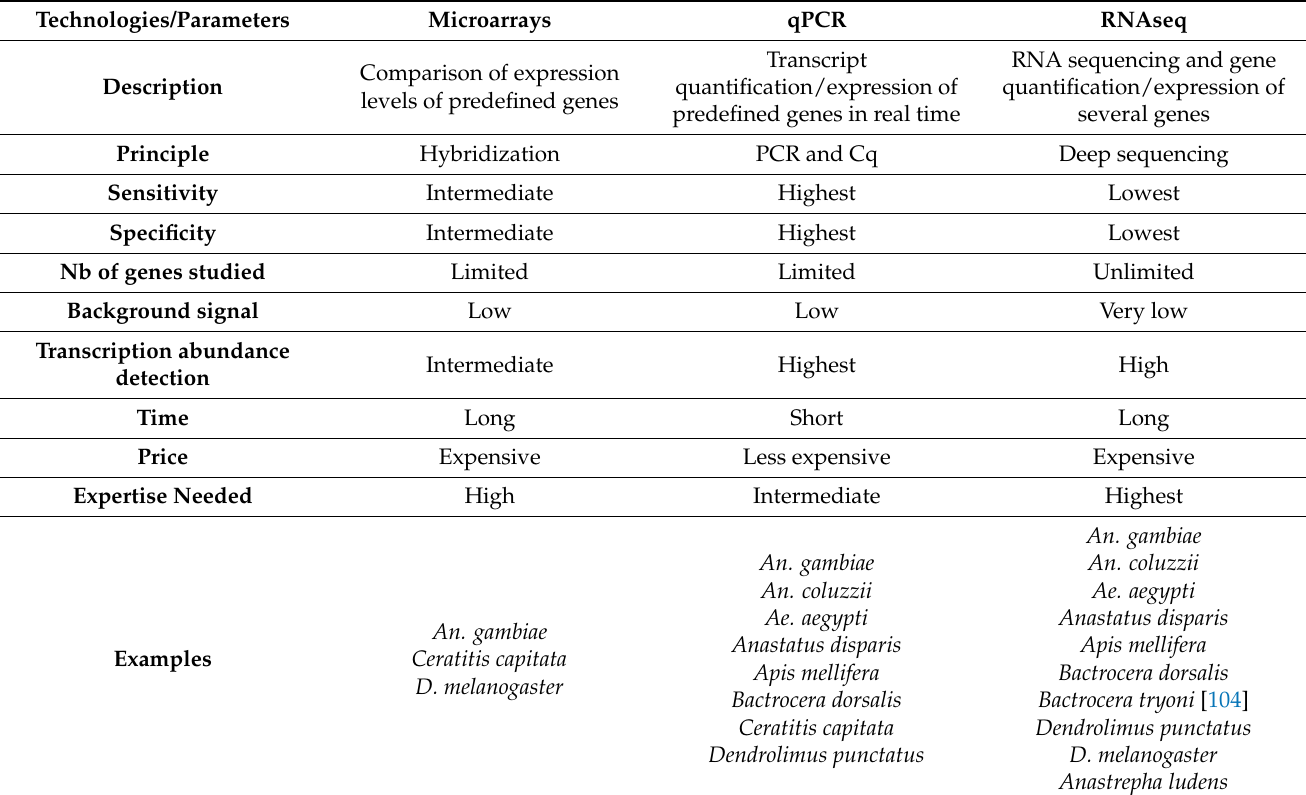
Table 1. Comparison of Approaches to Analyze Gene Expression Regulation Between Microarrays, qPCR and RNAseq. Nb for number. Cq stands for quantification